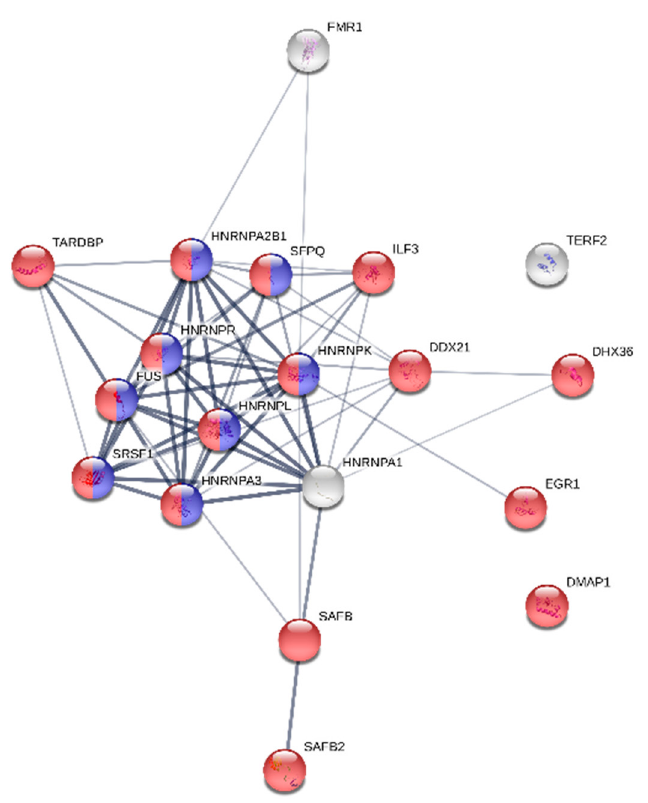
Figure 7. STRING Interaction network of quadruplex binding proteins containing at least two NIQI motifs. Eight quadruplex binding proteins in blue highlighted rings fall into GO:0000398 category (mRNA splicing, via spliceosome) with FDR = 2.12 × 10 − 8 . Sixteen quadruplex binding proteins in red highlighted rings fall into GO:0016070 category (RNA metabolic process) with FDR = 1.49 × 10 − 7 .